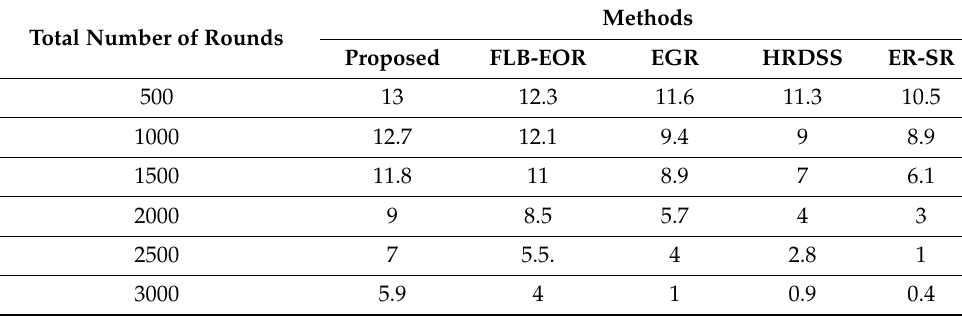
Figure 7. Comparative analysis of residual energy. Table 6. Comparative results based on residual energy.